Question: What type of chart is this?
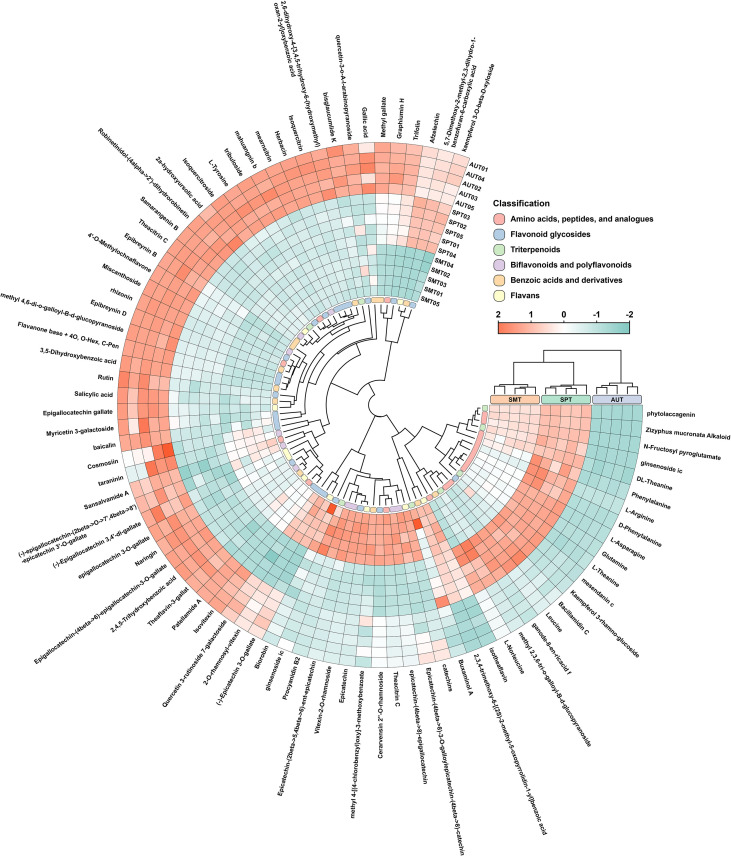
Answer: heatmap